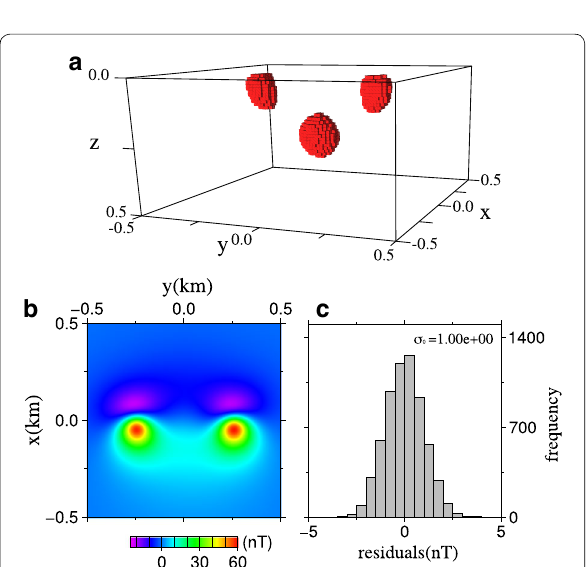
Fig. 11 An optimal model derived by L1–L2 norm regularized inversion. An optimal model derived by L1–L2 norm regularized α S 2 0.90 using weighting function w S 2 . a A inversion with ˆ = perspective view of the optimum model which displays all non-zero model elements, b total field anomaly computed by this model, and c histogram of the